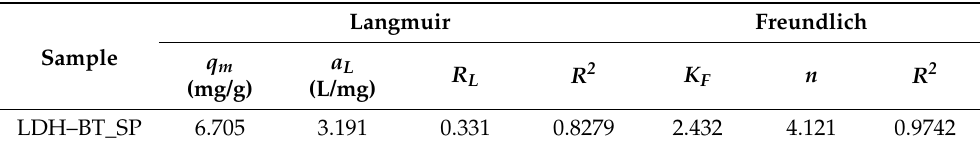
Table 2. The detailed parameters obtained from the Langmuir and Freundlich adsorption isotherm